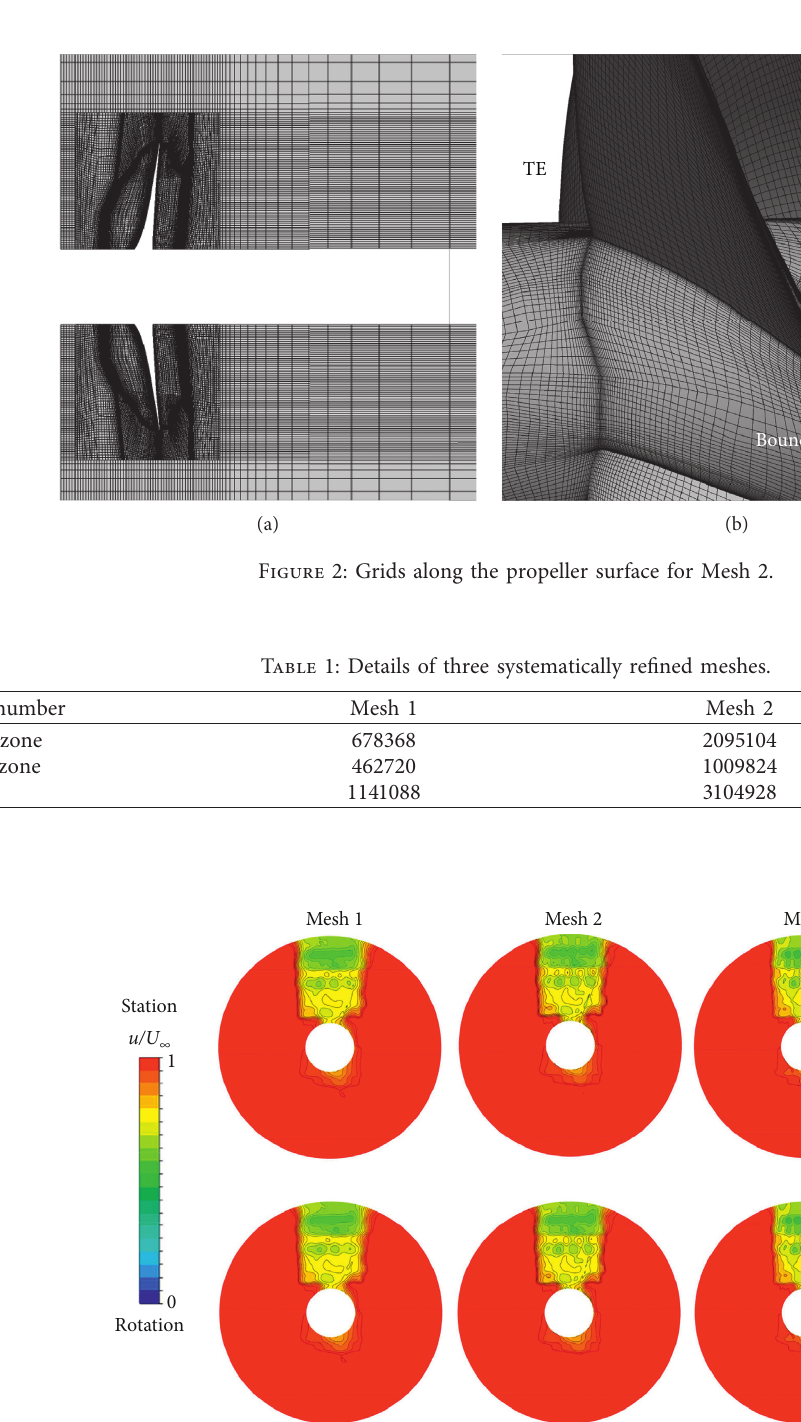
Figure 3: Comparison of axial velocity component at the stationary and rotating